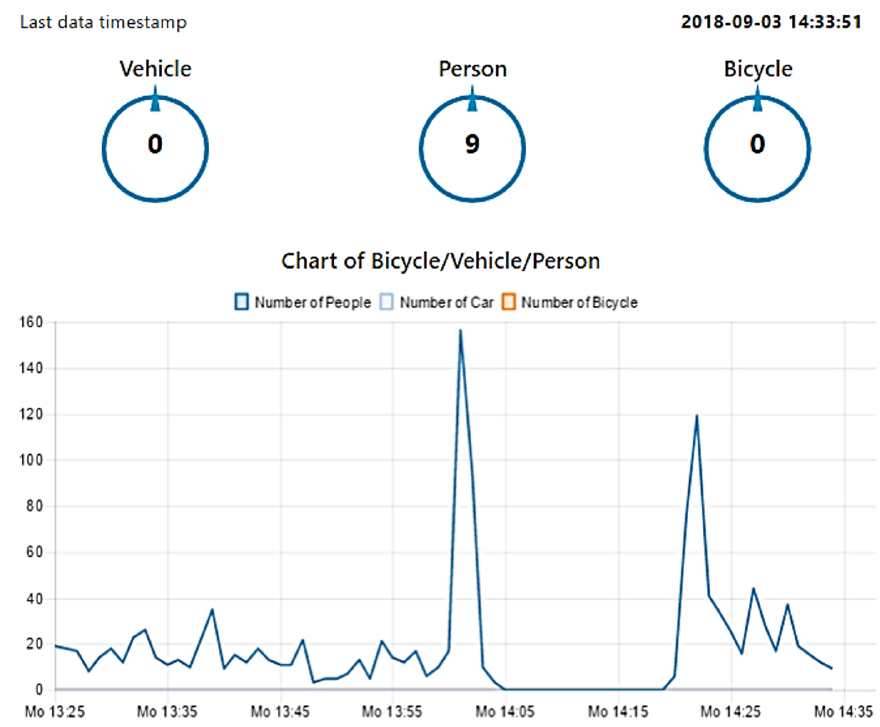
Figure 14. Plot of the number of people detected inside a building over one hour. The two peaks correspond to the start and end of the fire alarm